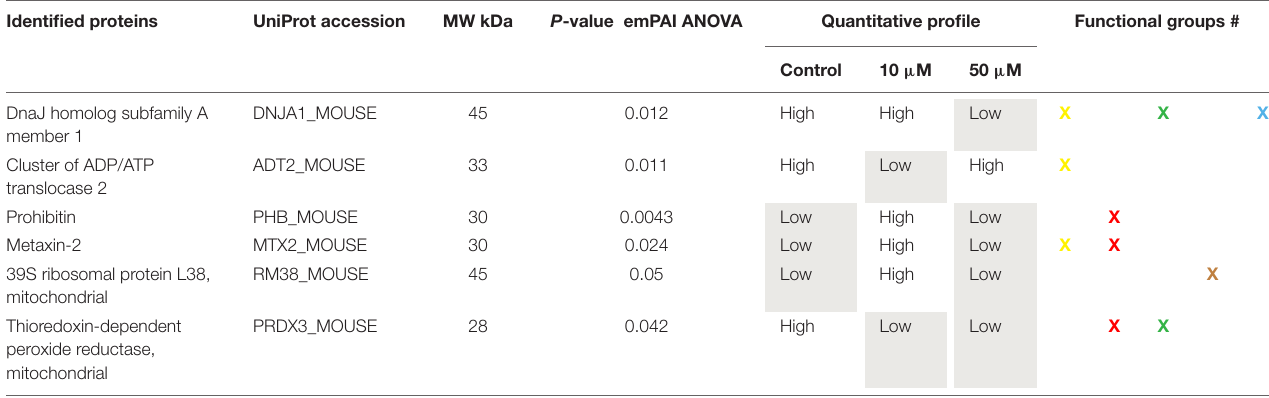
TABLE 1 | Differentially expressed mitochondrial proteins in fibroblasts after treatment with 10 or 50 µ M 3O-C 12 -HSL for 4 h compared to the diluent control. Identified proteins